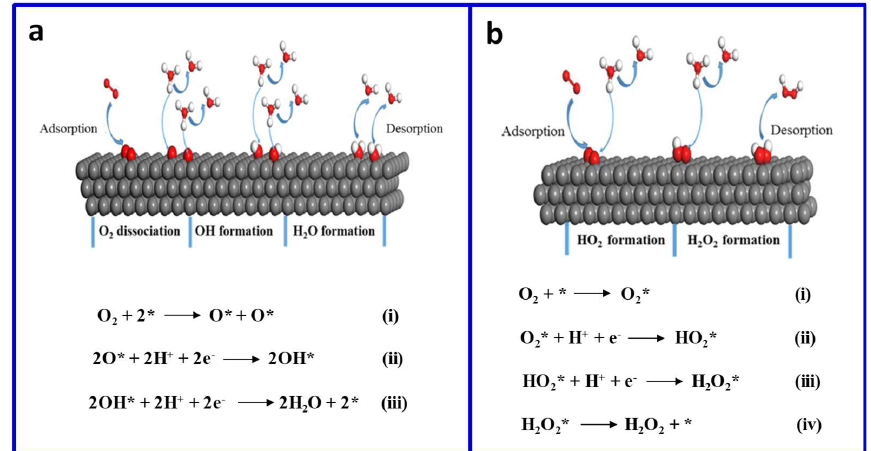
Figure 3. Proposed mechanism schematics of ( a ) full reduction and ( b ) partial reduction of oxygen. Reproduced from [47], Copyright 2016, Elsevier.